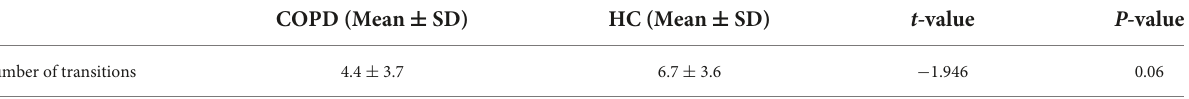
TABLE 5 Two sample t -tests of number of transitions between the COPD and HC. COPD (Mean ± SD) HC (Mean ± SD) t- value P- value Number of transitions 4.4 ± 3.7 6.7 ± 3.6 − 1.946